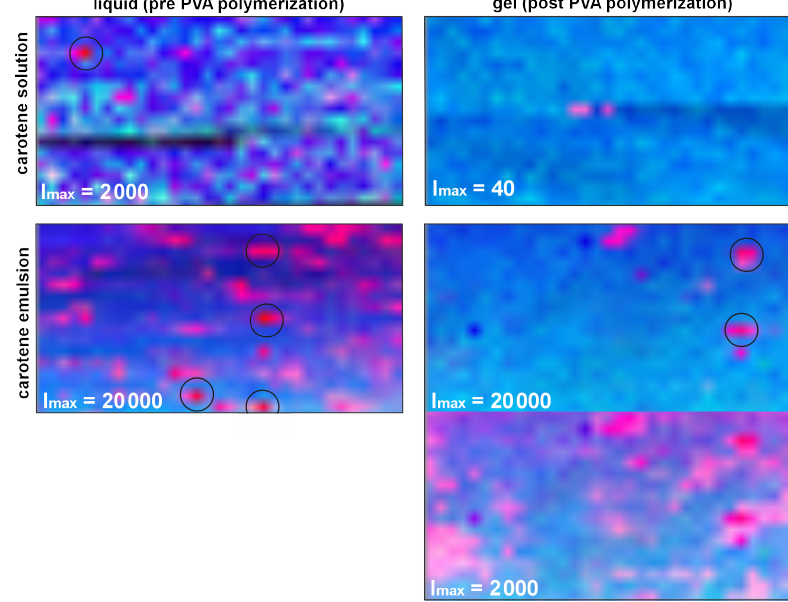
Figure 24. Raman images of liquid ( left ) and polymerized ( right ) PVA hydrogels that were stained with β -carotene solved in ethanol ( top ) or β -carotene in emulsion ( bottom ). Water is color-coded in blue and PVA in green yielding turquoise for the hydrogel matrix. The distribution of β -carotene is shown in red. As color saturation encodes signal intensity, carotene distribution appears as different shades of pink in dependence of the β -carotene concentration. Please note that full color saturation refers to different maximal carotenoid signal intensities I max (a.u.) in the different images. Circles mark carotenoid agglomerations where exceptionally high β -carotene concentration and very weak water and PVA concentrations are found. The double image at the bottom right shows the same image (polymerized PVA hydrogel stained with β -carotene in emulsion) at two different carotenoid color scales to illustrate the large local variability of β -carotene concentration in the hydrogel. Each image shows a 100 µm wide sub-surface area of the gels (reproduced with permission from